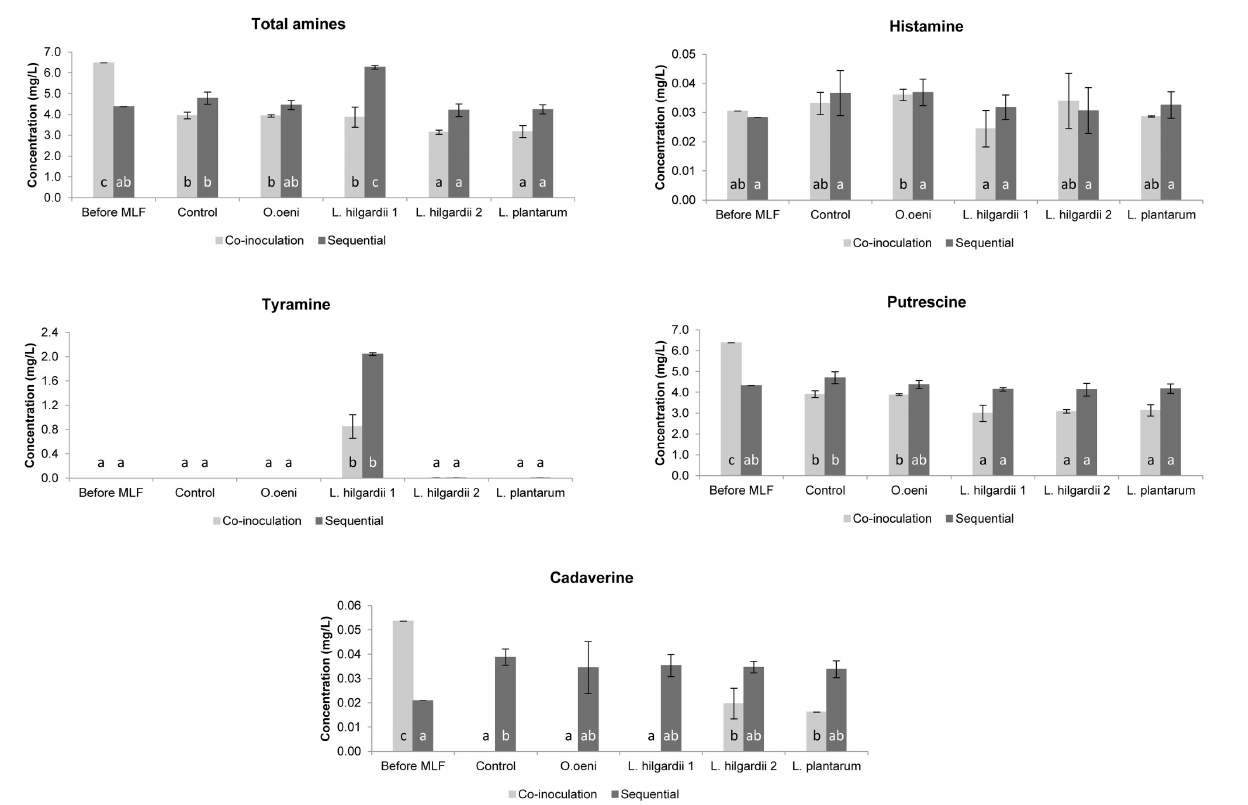
FIGURE 6 |The individual and total biogenic amine content of all treatments in the Shiraz wine fermentations before and after MLF. Each bar indicates the mean and the SEM. Different letters indicate significant differences ( p < 0.05) between treatments of the same MLF inoculation